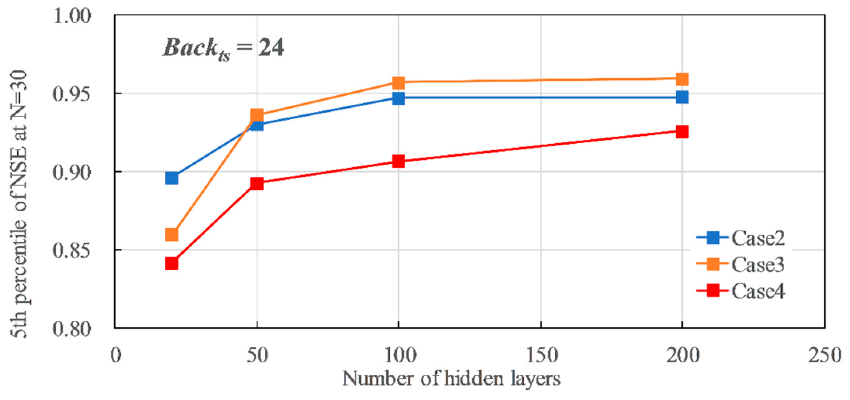
Figure 14. Influence of number of hidden layers on the 5th percentile of NSE, when Back ts = 24.